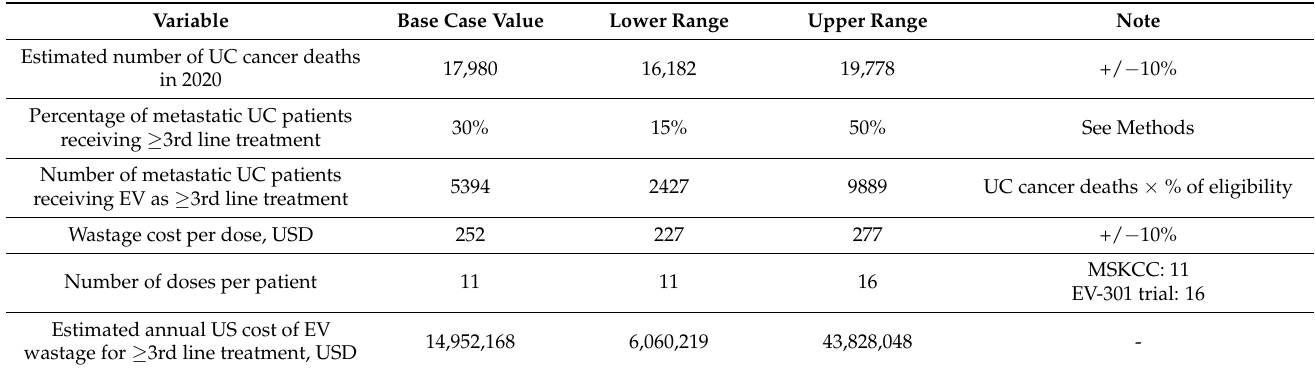
Table 2. Sensitivity analysis.